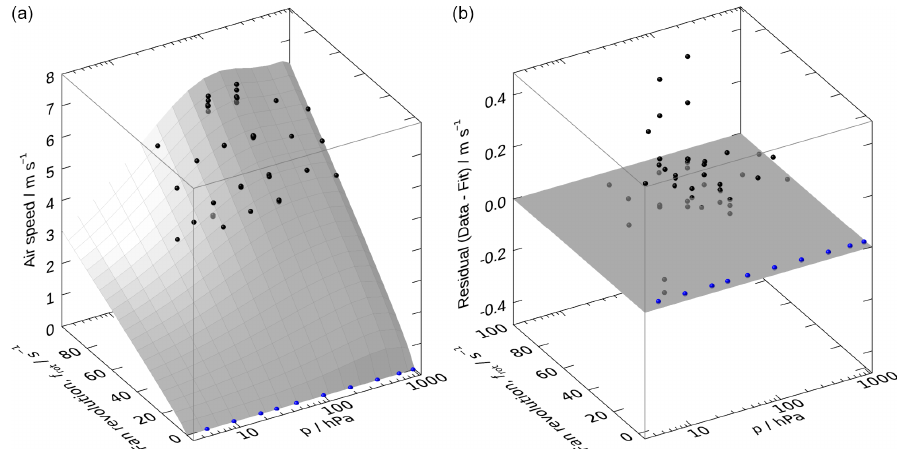
Figure 4. Flow speed as function of pressure and fan rotation (in revolutions per second). (a) Symbols denote measured flow speed around the central axis of the test chamber close to the sensor boom of the radiosonde. Blue symbols are manually added points for vanishing flow (fan switched off) to enable reasonable fitting. The surface shows the fit according to the empirical model (Eq. 1). (b) Equivalent plot for the residual, indicating irregular deviations of the data from the fit within about ± 0.5ms − 1 . Note the logarithmic pressure axis for better visibility at low